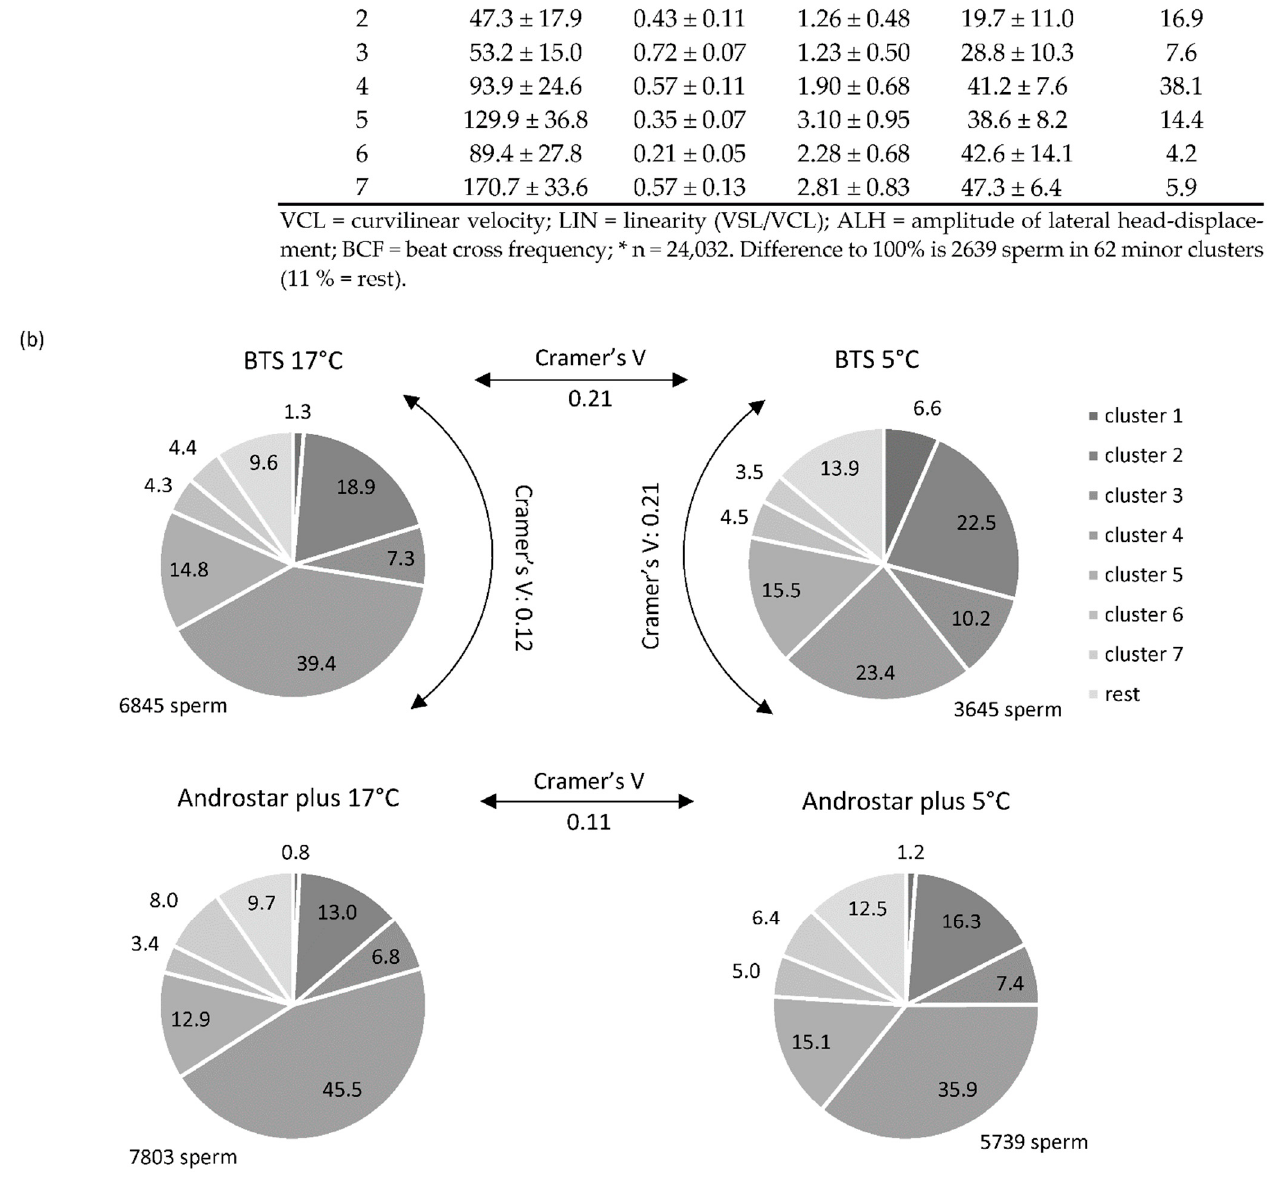
Figure 2. Effect of storage temperature and semen extender on the distribution of sperm in seven major kinematic clusters. ( a ) Subpopulations of motile spermatozoa as defined by cluster analysis of single sperm data from all motile cells. ( b ) The subpopulations structure for samples stored for 24 h at 17 °C or 5 °C in either Beltsville Thawing Solution (BTS) or Androstar ® Plus. All values are percentages. Chilling to 5 °C resulted in a significant change in sperm distribution to the different subpopulations, i.e., cluster ( p < 0.05). Cramer’s V indicates the effect size of the different storage temperatures or the semen extender on the distribution of the sperm to the different subpopulations (range: 0–1). The following guidelines were used for interpretation: V < 0.10 = no effect, 0.10 < V ≤ 0.30 = small effect, 0.30 < V ≤ 0.50 = moderate effect.